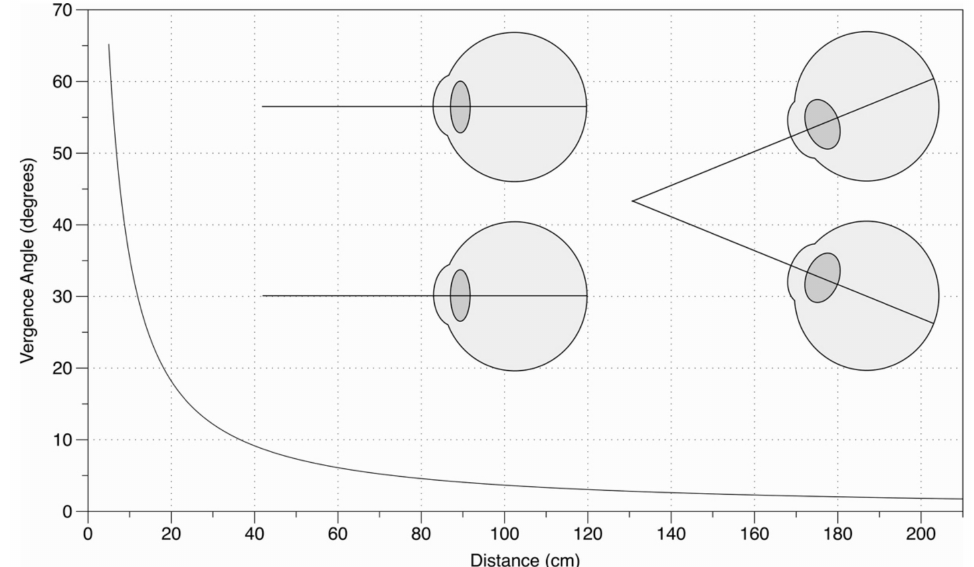
Figure 8. Fall off of vergence angle with distance from [15]. Just as with disparity, the vergence angle falls off as a function of 1/distance 2